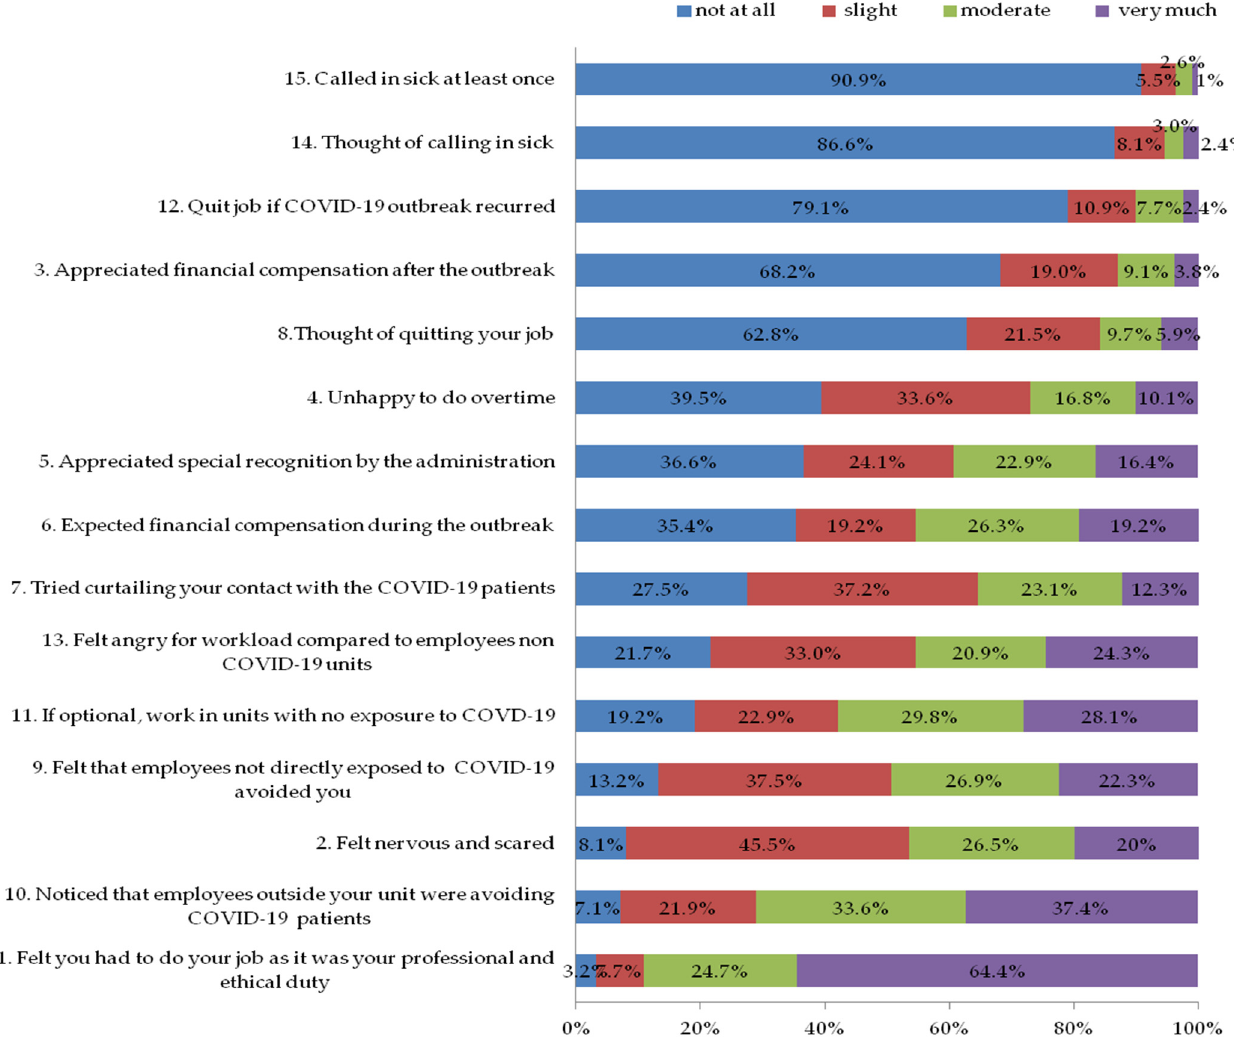
Figure 1. Staff emotions during COVID-19 outbreak.